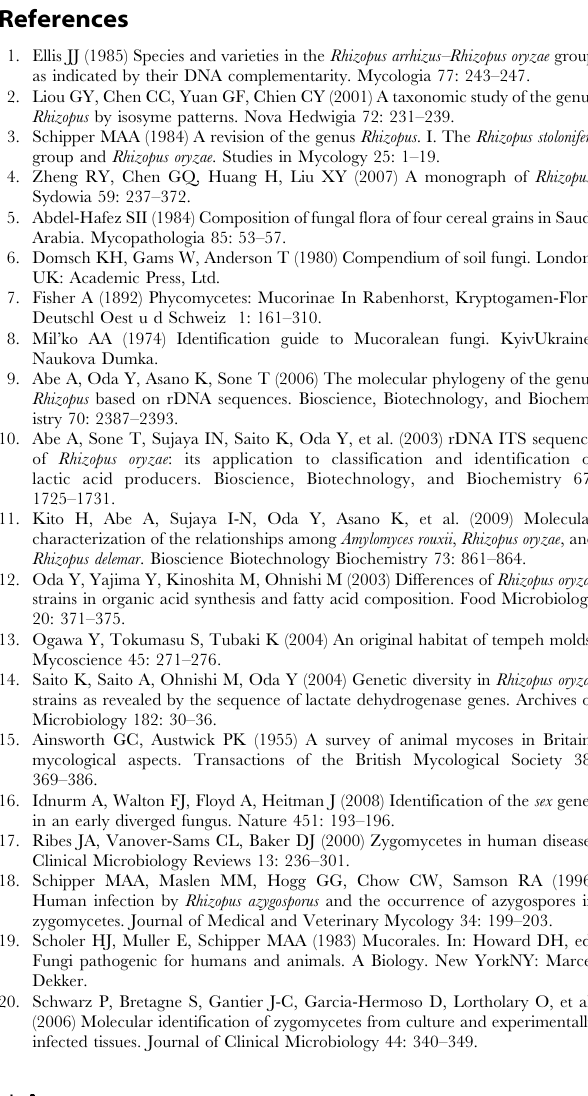
bar = 20 m m. (TIF) Figure S3 Micromorphology of sporangiospores. Panel A) Rhizopus delemar (from top to bottom): ATCC34612, RA99-880, NRRL3562. Panel B) Rhizopus oryzae s. s.(from top to bottom): NRRL2908, Duke99-133, NRRL3142. Panel C) Germination of the Rhizopus oryzae s. s. strain, CBS112.07. Scale = 1 m m for panel A and B, and 5 m m for panel C. (TIF) Table S1 List of primers designed in this study. (DOC) Table S2 GenBank accession numbers of the sequences generated in this study. Table S3 Isolates of the Rhizopus oryzae complex and related species used in this study; isolates of Rhizopus oryzae and Rhizopus delemar are named according to their placement in phylogenetic trees (See